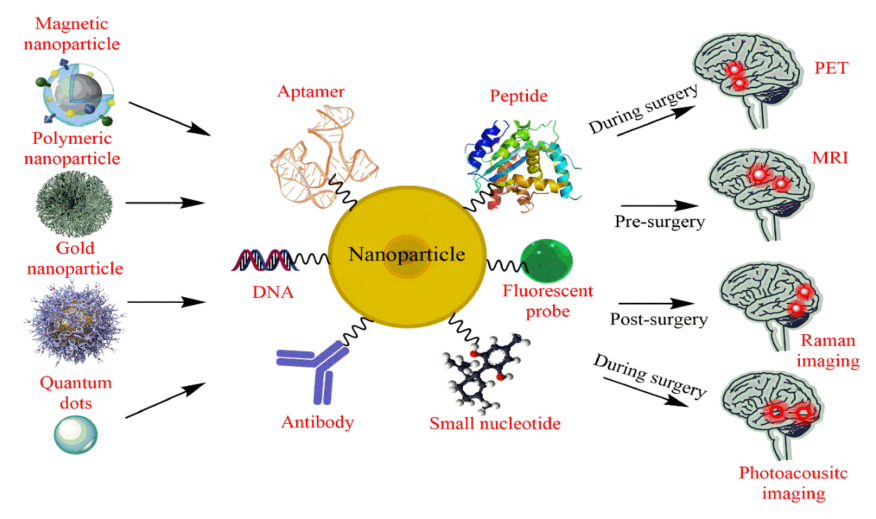
Figure 6. Nanomaterial-based imaging technology for improved diagnosis and surgery. Table 1. Di ff erent technologies utilizing nanostructures as a platform in the diagnosis and imaging of brain cancer /